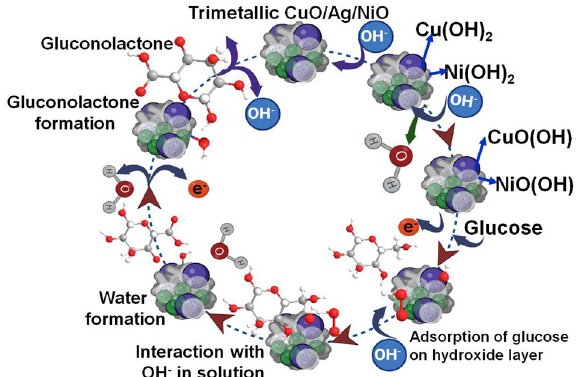
Figure 5. Mechanism of the trimetallic electrode for producing glucose to